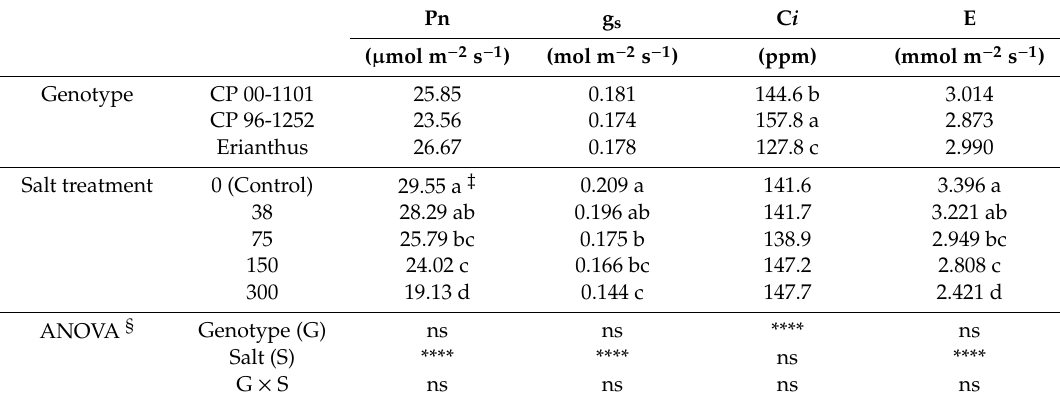
Table 1. Leaf net photosynthetic rate (Pn), stomatal conductance (g s ), intercellular CO 2 concentration (C i ), and transpiration rate (E) of two sugarcane cultivars (CP 00-1101, CP 96-1252) and an Erianthus as a ff ected by salt (NaCl) concentration (mM) with analysis of variance (ANOVA) of genotype and salt main e ff ects and their interactions † .